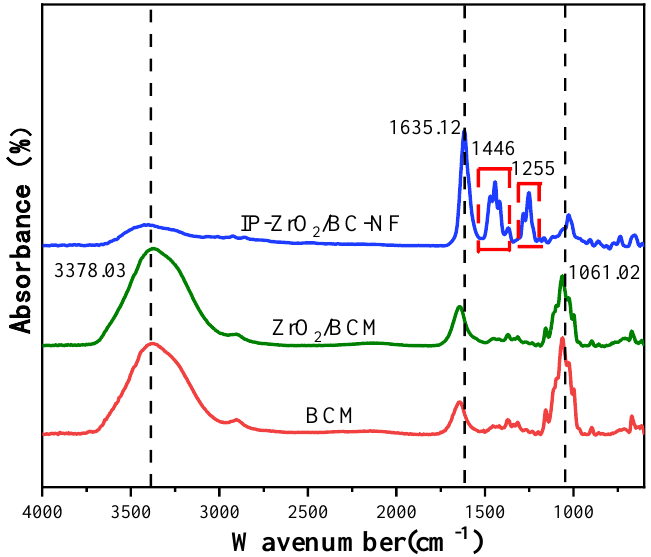
Figure 10. FT − IR spectra for BCM and ZrO 2 /BCM, as well as IP − ZrO 2 /BC − NFM.